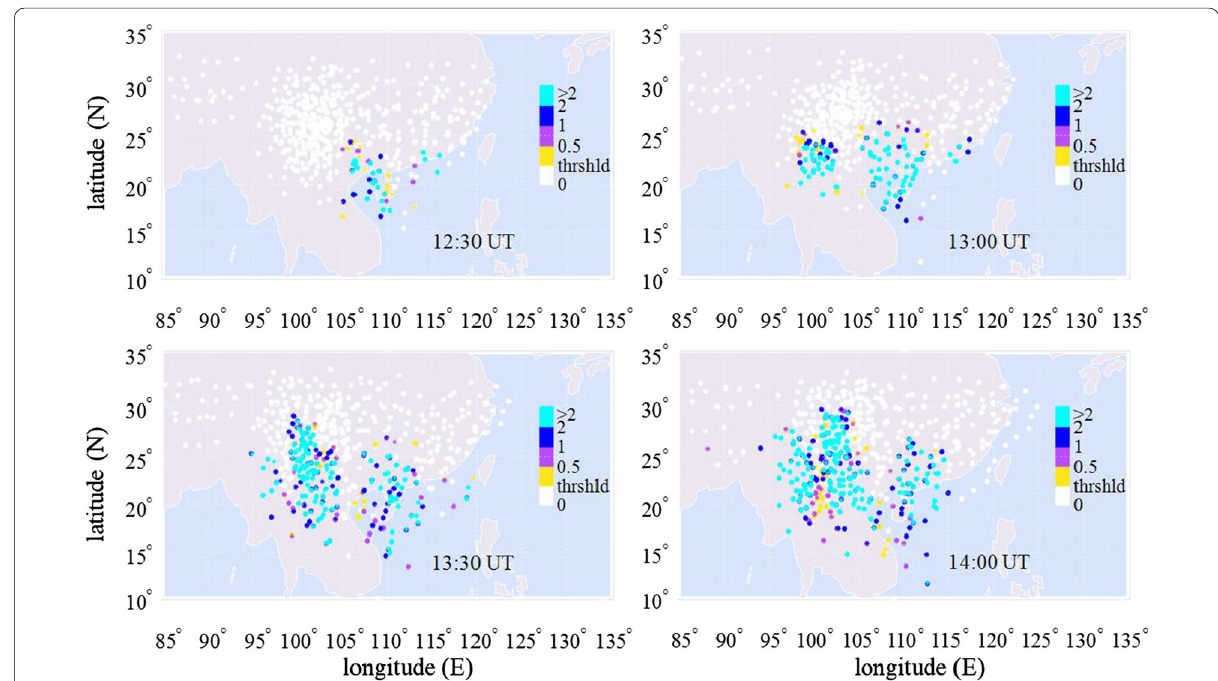
Fig. 2 Two-dimension ROTI maps from 12:30 to 14:00 UT on March 1st 2014. The horizontal and vertical axes are longitude and latitude, respectively. The dots with different colors represented different vROTI values as shown by the color bar